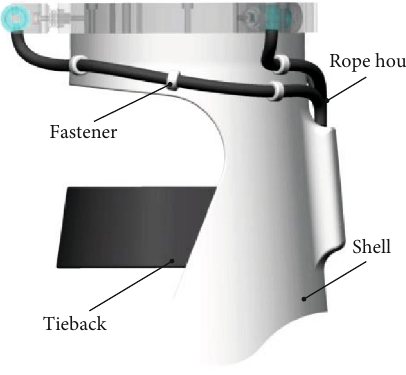
Figure 8: Structure of the wrist fi xing part.